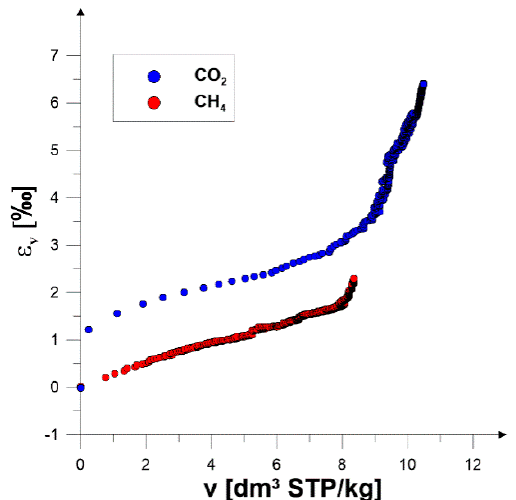
Figure 3. The dependence of the size of the volume deformation as a function of the sorption capacity of the tested sample.